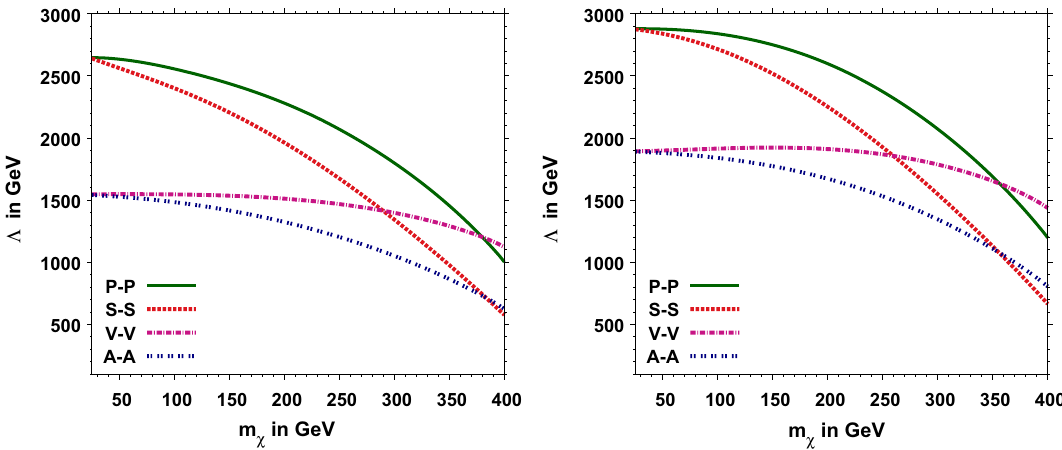
of e − and e + with an integrated luminosity of 1 ab − 1 . The contours √ s = 1 TeV at the right correspond to 80 and 30% polarised beam for e − and e + , respectively, with an integrated luminosity of 500 fb − 1 . The respective coupling of DM with the charged lepton α l is taken to be MN